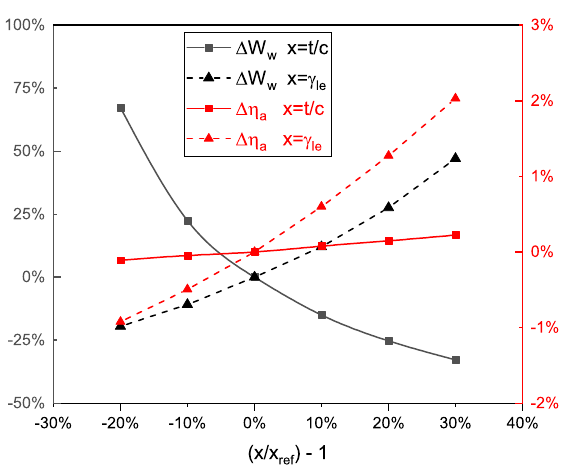
Figure 11. Influence of t/c and γ le on W w and η a , for a backward-swept wing. The influence of the above parameters on the forward-swept configuration is studied in Figure 12.